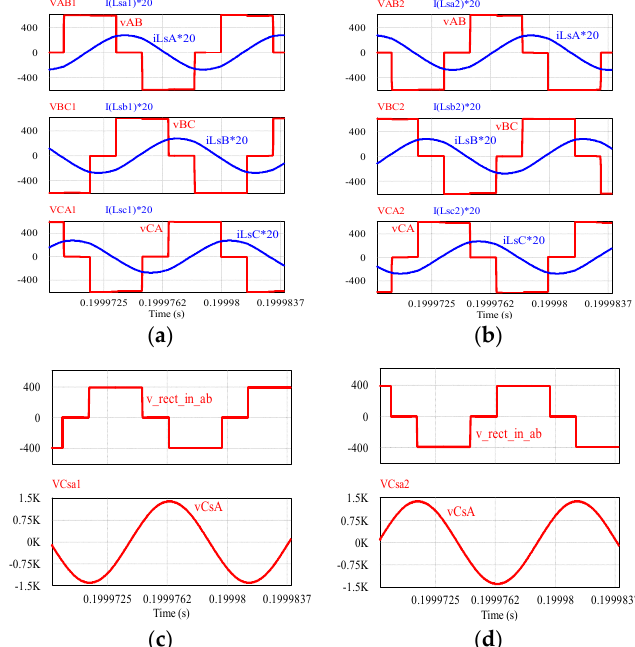
Figure 4. PSIM simulation waveforms for Case 1: V in (min) = 135 V, full load, R L = 16 Ω , δ = 180 ◦ . v AB , v BC , v CA , and i LsA , i LsB , i LsC for ( a ) Module 1 and ( b ) Module 2. v rect_in_ab or v Lab , and v CsA for ( c ) Module 1 and ( d ) Module